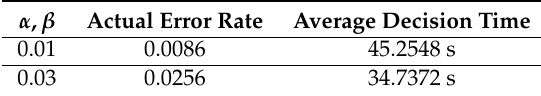
Table 2. Simulation results of HSTC.